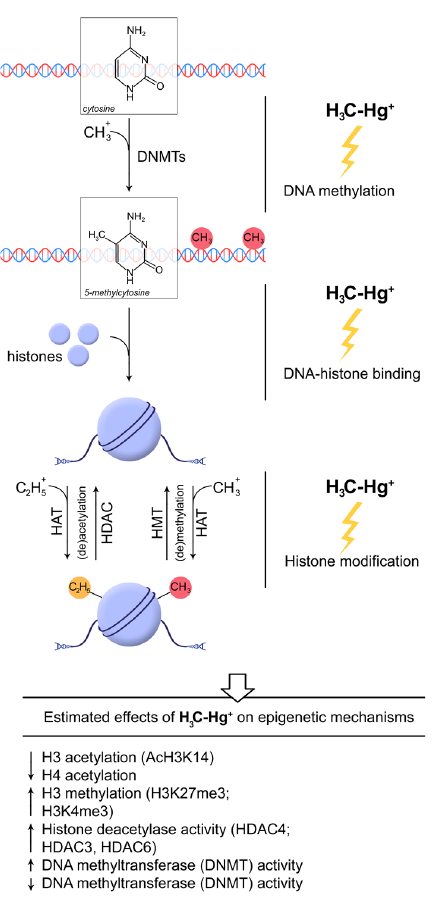
Figure 2. Epigenetic mechanisms potentially involved in MeHg-induced neurotoxicity [18,52,53,83,89–91]. Epigenetic effects of MeHg exposure may be mediated through a number of mechanisms including modulation of DNA methylation, histone-DNA binding, and histone modifications. Specifically, MeHg was shown to modulate DNMT activity resulting in significant changes in DNA methylation, although both up-regulation and down-regulation of DNMT was reported. Alteration in DNA-histone binding may ultimately result in impaired nucleosome formation, also corresponding to the earlier reported effect of MeHg on chromatin compactness and structure. MeHg was also shown to affect histone modification with reduction of histone 3 and 4 acetylation due to up-regulation of HDAC4, as well as HDAC 3 and 6 activity. Although stimulatory effect of MeHg on histone 3 methylation was demonstrated, the particular impact of MeHg on regulatory enzymes including HMT and HDM is still unclear. It is expected that these mechanisms may at least partially mediate the impact of MeHg on molecular targets underlying its neurotoxicity (e.g., inhibition of BDNF signaling). Author Contributions: T.K. and M.A. conceptualized the work and wrote the first draft. A.A.T., A.V.S., A.S., J.B.T.R., A.B.B. and W.C. edited and revised the manuscript. T.K. prepared Figure 1. A.A.T. prepared Figure 2. All authors have read and agreed to the published version of the manuscript. Funding: This work was supported by the National Institute of Environmental Health Sciences (NIEHS R01ES007331) to M.A. and A.B.B. Institutional Review Board Statement: Not applicable. Informed Consent Statement: Not applicable. Data Availability Statement: No new data were created or analyzed in this study. Data sharing is not applicable to this article. Conflicts of Interest: The authors declare no conflict of interest.